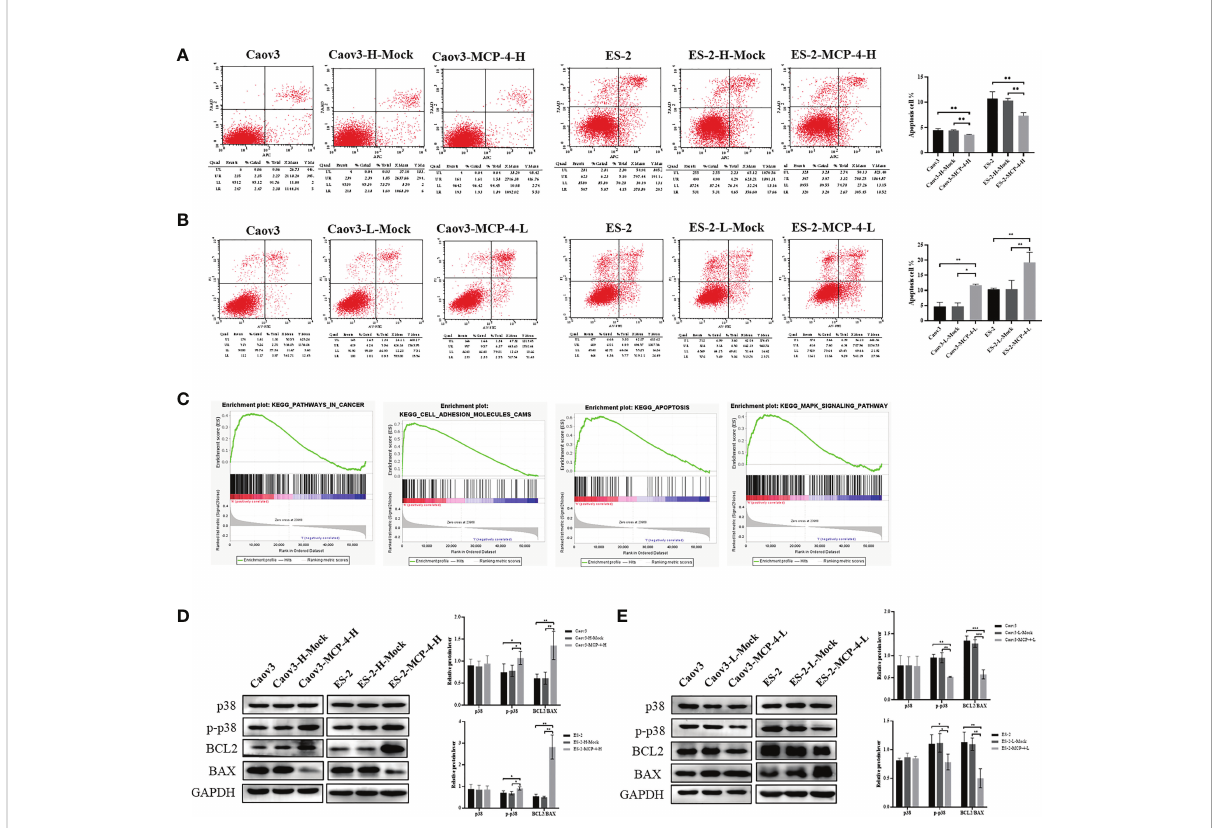
FIGURE 5 MCP-4 decreased cell apoptosis and activated the p38 MAPK signaling pathway. (A) Overexpression of MCP-4 decreased cell apoptosis of Caov3 and ES-2 cell lines (B) Inhibition of MCP-4 expression increased ovarian cancer cells apoptosis. (C) GSEA analysis of MCP-4 related enrichment gene sets. KEGG_PATHWAYS_IN_CANCER (NES = 1.64, P-value = 0.024, FDR = 0.059); KEGG_APOPTOSIS (NES = 2.20, P-value = 0.000, FDR = 0.000); KEGG_CELL_ADHESION_MOLECULES_CAMS (NES = 2.39, P-value = 0.000, FDR =